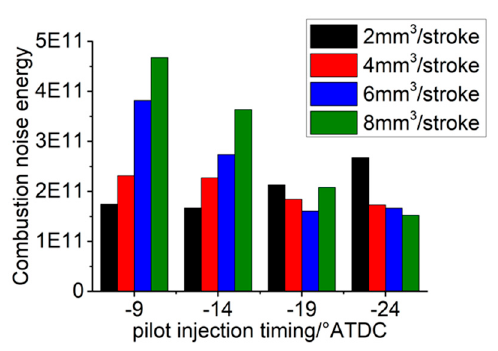
Figure 12. Overall combustion noise energy.